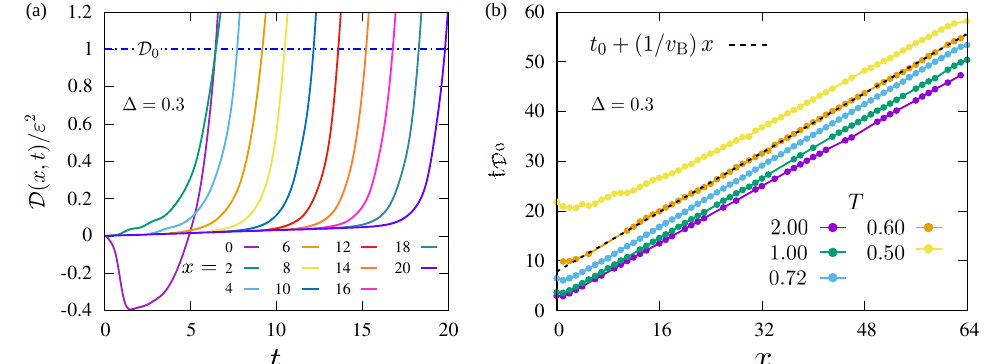
Figure 11: Extraction of the butterfly speed and the delay time: (a) shows the time dependence of D ( x , t ) /(cid:34) 2 at different sites ( x = 0,2,4,...) along a 1d cut in the x - direction at T = 0.72 for easy-plane anisotropy. Due to the choice of our orthogonal = (cid:34) ( ˆ n × S ) , D ( x , t ) starts from 0 and increases to reach D = (cid:34) 2 in perturbation, δ S 0 0 0 time t . Initially D ( x , t ) becomes negative, before rising sharply to D . (b) shows D 0 0 ( x , t ) = 0 or D ( x , t ) = D the light cones t obtained from the locus of λ . The D 0 L 0 = t + x / v ( T ) and t ( T ) . We get similar light cones are fitted with t to extract v D 0 B B 0 0 behaviour for easy-axis case.